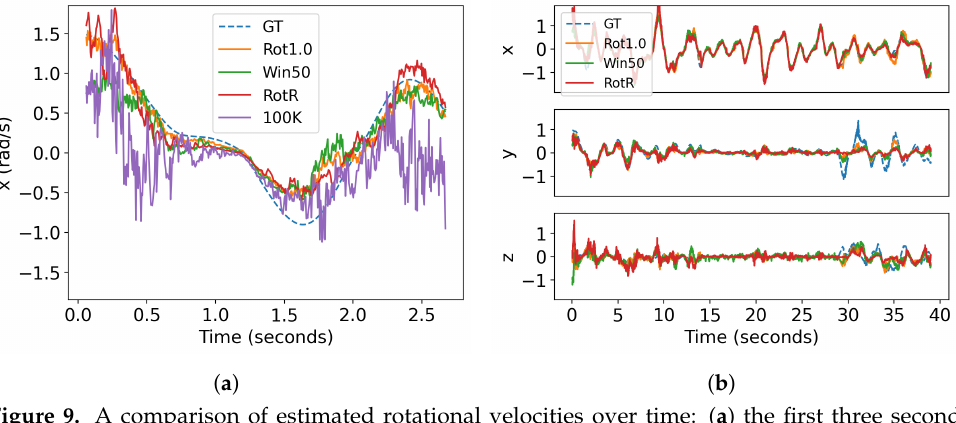
Figure 9. A comparison of estimated rotational velocities over time: ( a ) the first three seconds of x-velocity prediction on the room dataset and ( b ) the rotation velocity estimation compared to